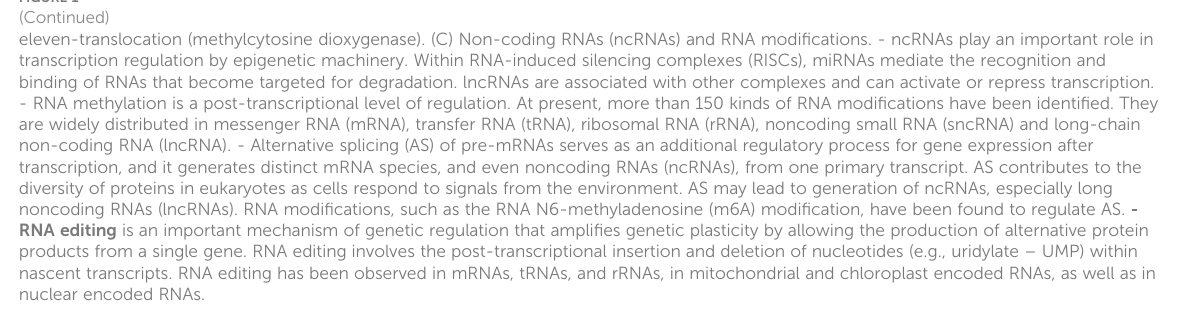
FIGURE 1 eleven-translocation (methylcytosine dioxygenase). (C) Non-coding RNAs (ncRNAs) and RNA modi fi cations. - ncRNAs play an important role in transcription regulation by epigenetic machinery. Within RNA-induced silencing complexes (RISCs), miRNAs mediate the recognition and binding of RNAs that become targeted for degradation. lncRNAs are associated with other complexes and can activate or repress transcription. - RNA methylation is a post-transcriptional level of regulation. At present, more than 150 kinds of RNA modi fi cations have been identi fi ed. They are widely distributed in messenger RNA (mRNA), transfer RNA (tRNA), ribosomal RNA (rRNA), noncoding small RNA (sncRNA) and long-chain non-coding RNA (lncRNA). - Alternative splicing (AS) of pre-mRNAs serves as an additional regulatory process for gene expression after transcription, and it generates distinct mRNA species, and even noncoding RNAs (ncRNAs), from one primary transcript. AS contributes to the diversity of proteins in eukaryotes as cells respond to signals from the environment. AS may lead to generation of ncRNAs, especially long noncoding RNAs (lncRNAs). RNA modi fi cations, such as the RNA N6-methyladenosine (m6A) modi fi cation, have been found to regulate AS. - RNA editing is an important mechanism of genetic regulation that ampli fi es genetic plasticity by allowing the production of alternative protein products from a single gene. RNA editing involves the post-transcriptional insertion and deletion of nucleotides (e.g., uridylate – UMP) within nascent transcripts. RNA editing has been observed in mRNAs, tRNAs, and rRNAs, in mitochondrial and chloroplast encoded RNAs, as well as in nuclear encoded